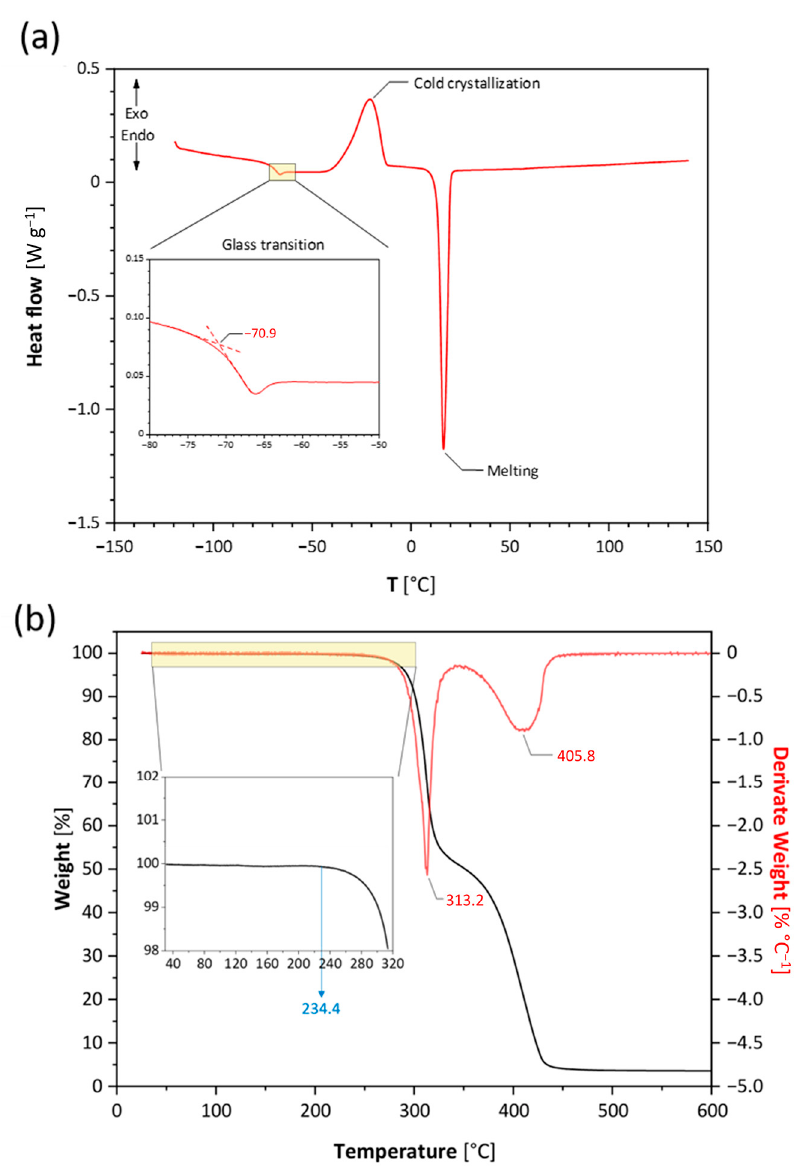
Figure 3. DSC heating scan ( a ), TGA curve ( b , black) and its derivate ( b , red) of Pip 13 DFOB.